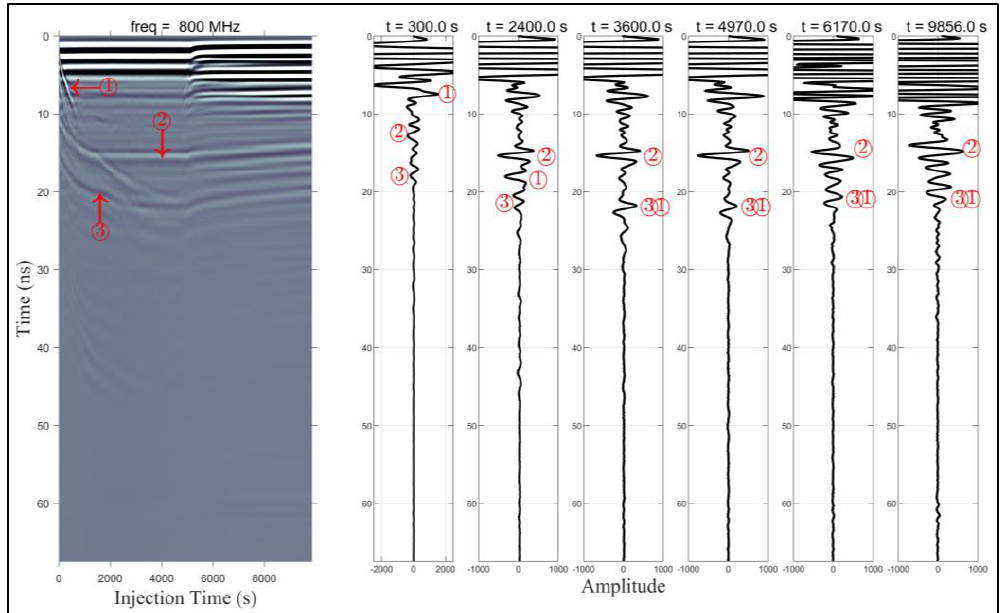
Figure 13. Six traces from the GPR profile. The numbers 1, 2, and 3 stand for the reflections coming from the water front, the boundary between two sandy layers, and the water table, respectively (Author’s own work) [56].